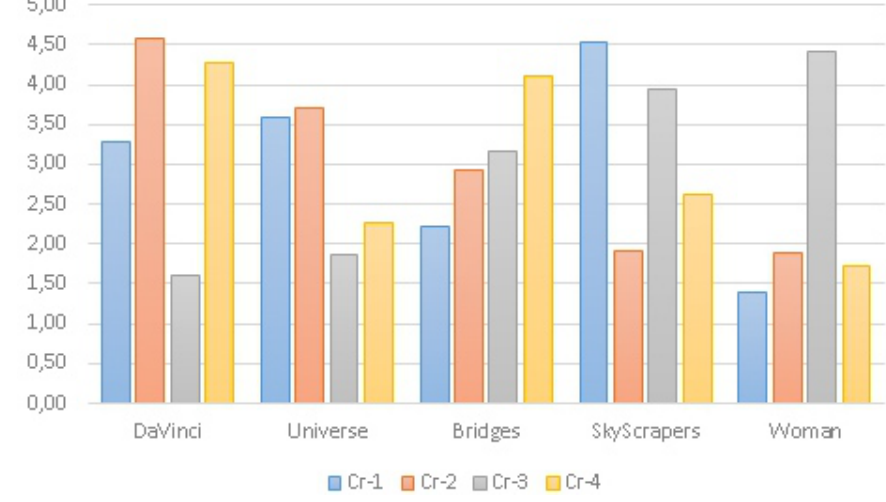
Figure 5: Diagram of distribution of expert assessments according to criteria